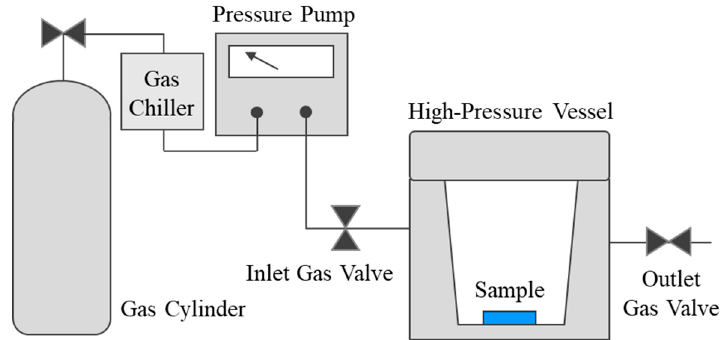
Figure 1. High-pressure vessel for batch foaming process.